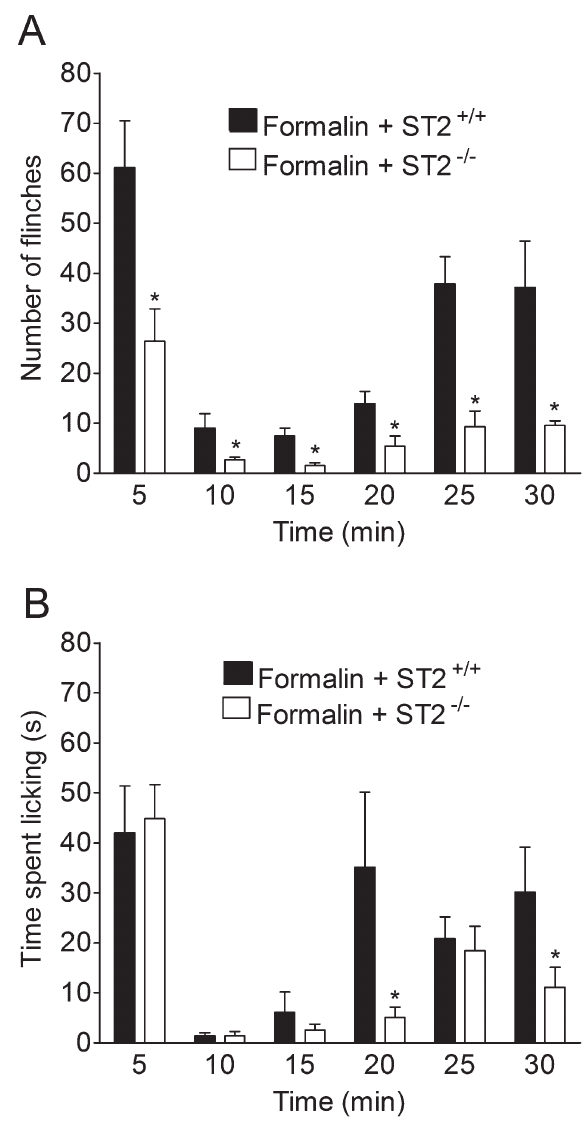
Figure 3. Role of IL-33/ST2 receptor in formalin-induced paw flinching ( A ) and time spent licking ( B ). ST2 +/++ and ST2 -/- mice received an intraplantar injection of 25 m L 2.5% formalin diluted in saline. The overt pain-like behavior was determined as the number of flinches and time spent licking the paw for 30 min at 5- min intervals. n=7 per group per experiment, representative of two separate experiments. *P , 0.05, compared to the ST2 +/++ group (Student t (Figure 2B) induced by OVA challenge were reduced significantly in ST2 -/- mice, compared with ST2 +/++ mice. Vehicle (saline), in immunized mice, and OVA challenge in the sham-immunized group did not induce significant flinching or licking behaviors. ST2 -/- mice showed the same responses as ST2 +/++ mice in the sham-immunized